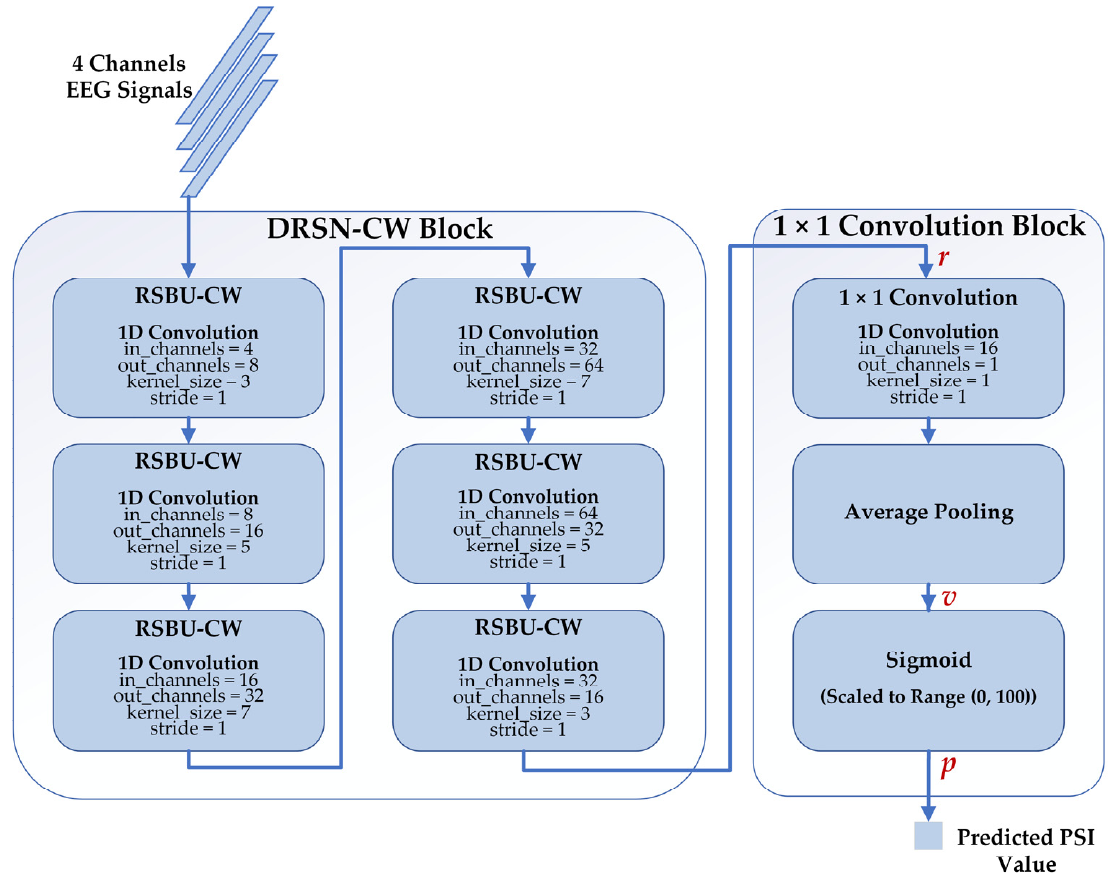
Figure 6. The structure of our proposed model consists of the DRSN-CW block and 1 × 1 convolution block. The inputs of our proposed model are 4 channel-EEG signals, and the outputs are the corresponding predicted PSI values.